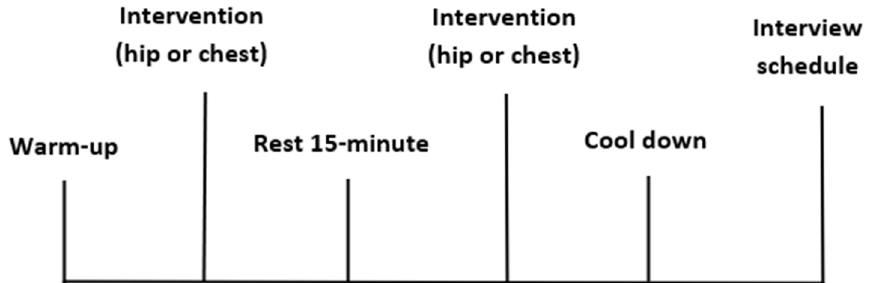
Figure 2. Study design timeline of the intervention protocol.